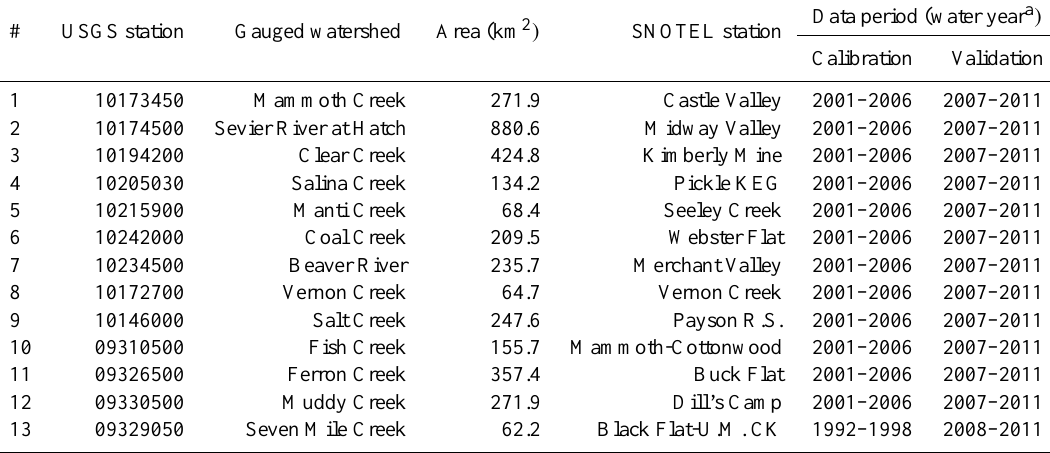
Table 1. Details of gauged watersheds and corresponding USGS and SNOTEL